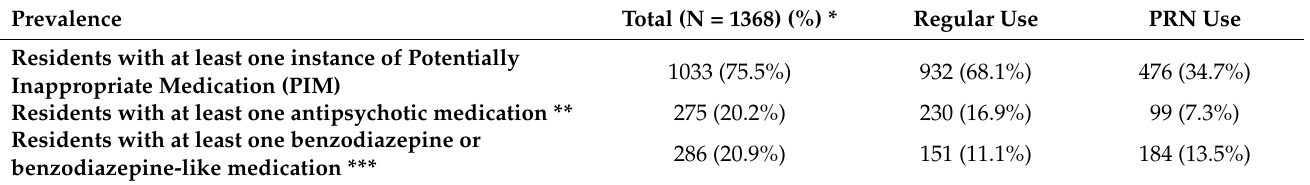
Table 2. Prevalence of QUM indicators.